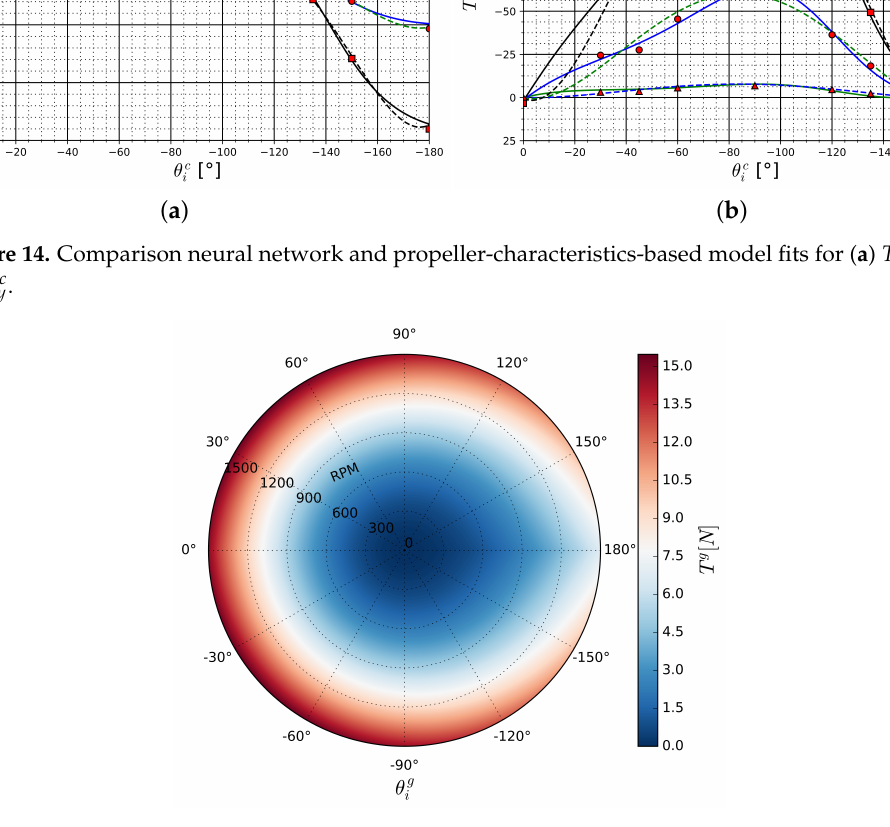
Figure 15. Visualisation of the possible magnitudes and orientations of T g modelled by the quadratic ) equals two, and a pure quadratic n g -depedency, thrust deduction model, i.e., polynomial order of t ( θ g i i.e., T m ( n ) = T nn n 2 , for a continuous area of ( θ g , n g ) pairs. The outer circumference of this plot shows i the same information as the quadratic polynomial at 1500 rpm of Figure